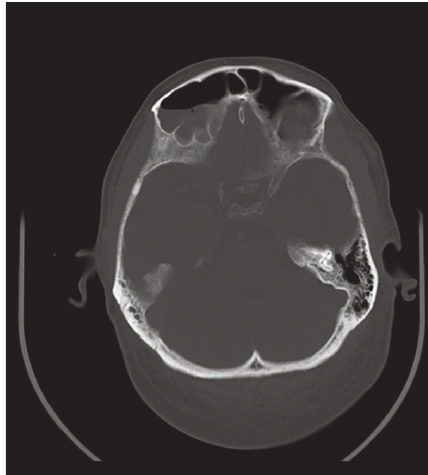
Figure 4: MR imaging of the cranium with air-fluid level in both frontal sinuses.